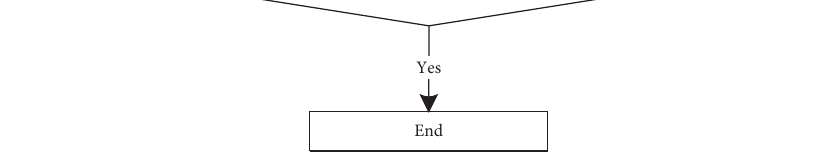
Figure 1: Flowchart of the heuristic algorithm based on the genetic